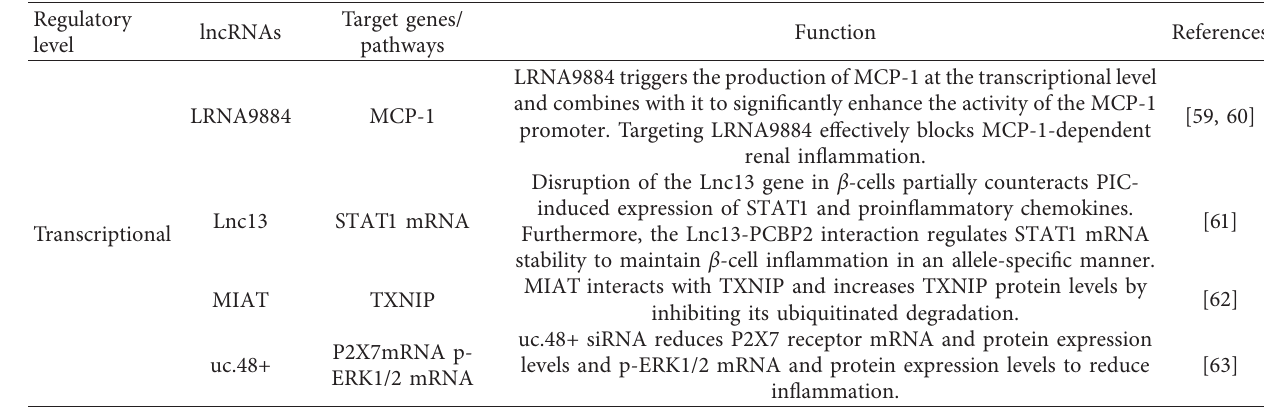
Table 2: The function of lncRNAs at the transcriptional